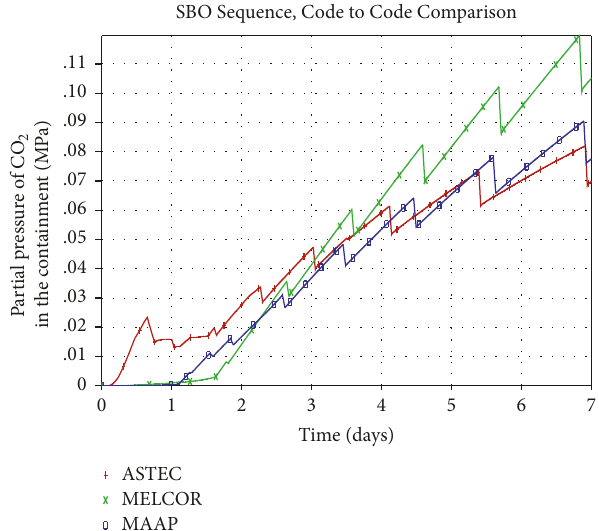
not go up like that of CO. Carbon dioxide is largely consumed in that process, so its release becomes significant only after the reinforcement remains the only material that can oxidize. After approximately 4-5 days CO 2 is the most important incondensable gas, Figure 8, which causes containment pres-